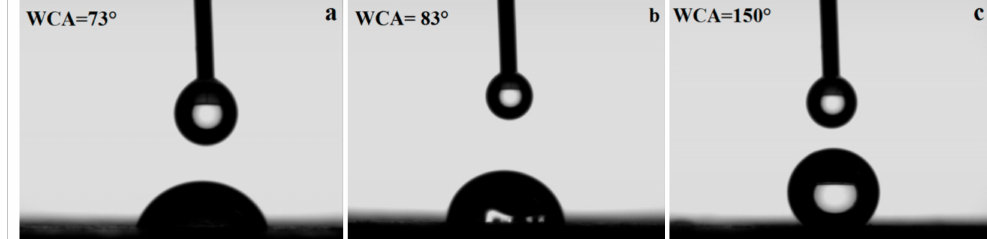
Figure 9. Images of 11 µ m water droplets on ( a ) uncoated wood, ( b ) TiO 2 -coated wood surface at v = 80 mm / s and ( c ) TiO 2 -coated wood surface at v = 40 mm /